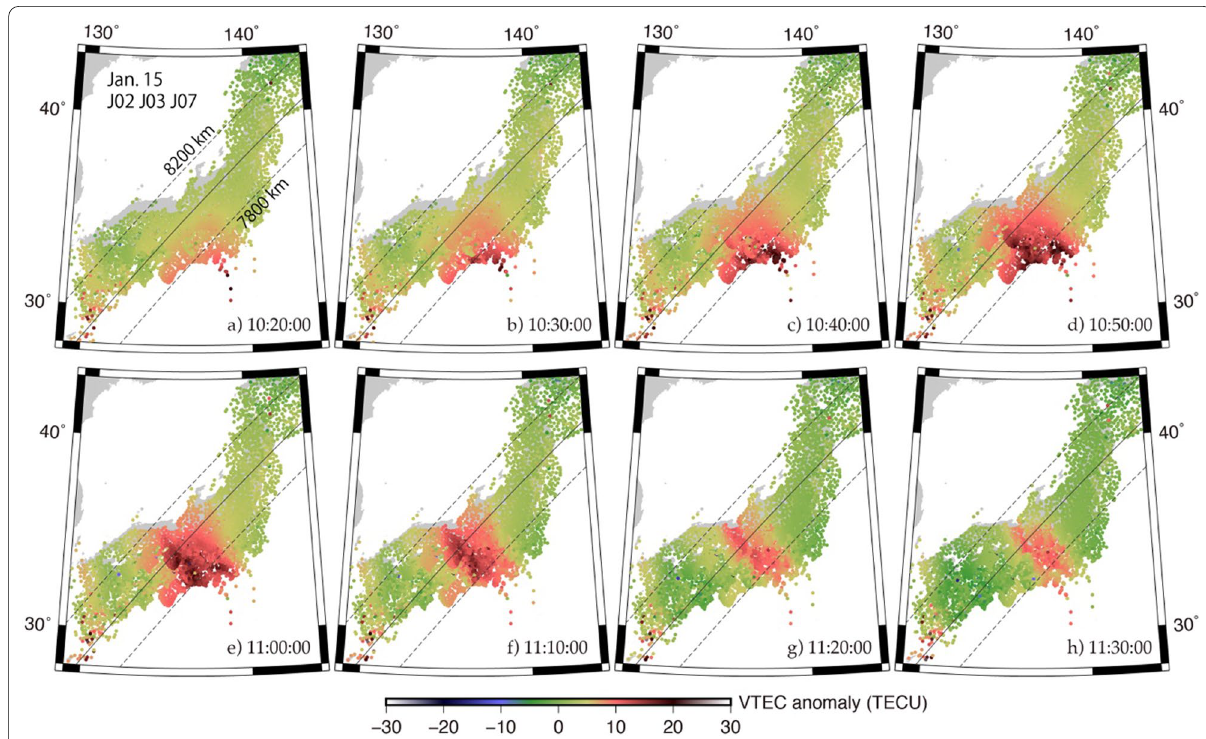
Fig. 7 Geographic distribution of the VTEC residuals at 8 epochs from Jan. 15, 10:20 UT ( a ) to 11:30 UT ( h ), from best-fit degree-4 polynomials estimated for t 7–18 excluding the data within t 9–14 (see Fig. S1 for the fit of such reference curves). I used all GNSS stations in Japan (small = = gray dots in Fig. 1) and three QZSS satellites J02, J03, and J07. The wavefront of the first LW passage is not so clear as Fig. 2 because of the existence of extremely large amplitude disturbances in Central Japan. The epoch of panel g corresponds to that of Fig.